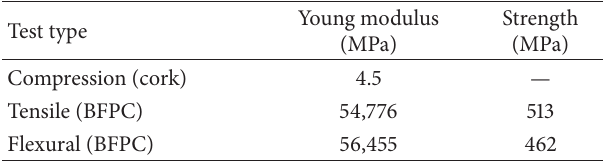
Table 2: Mechanical properties obtained for sandwich